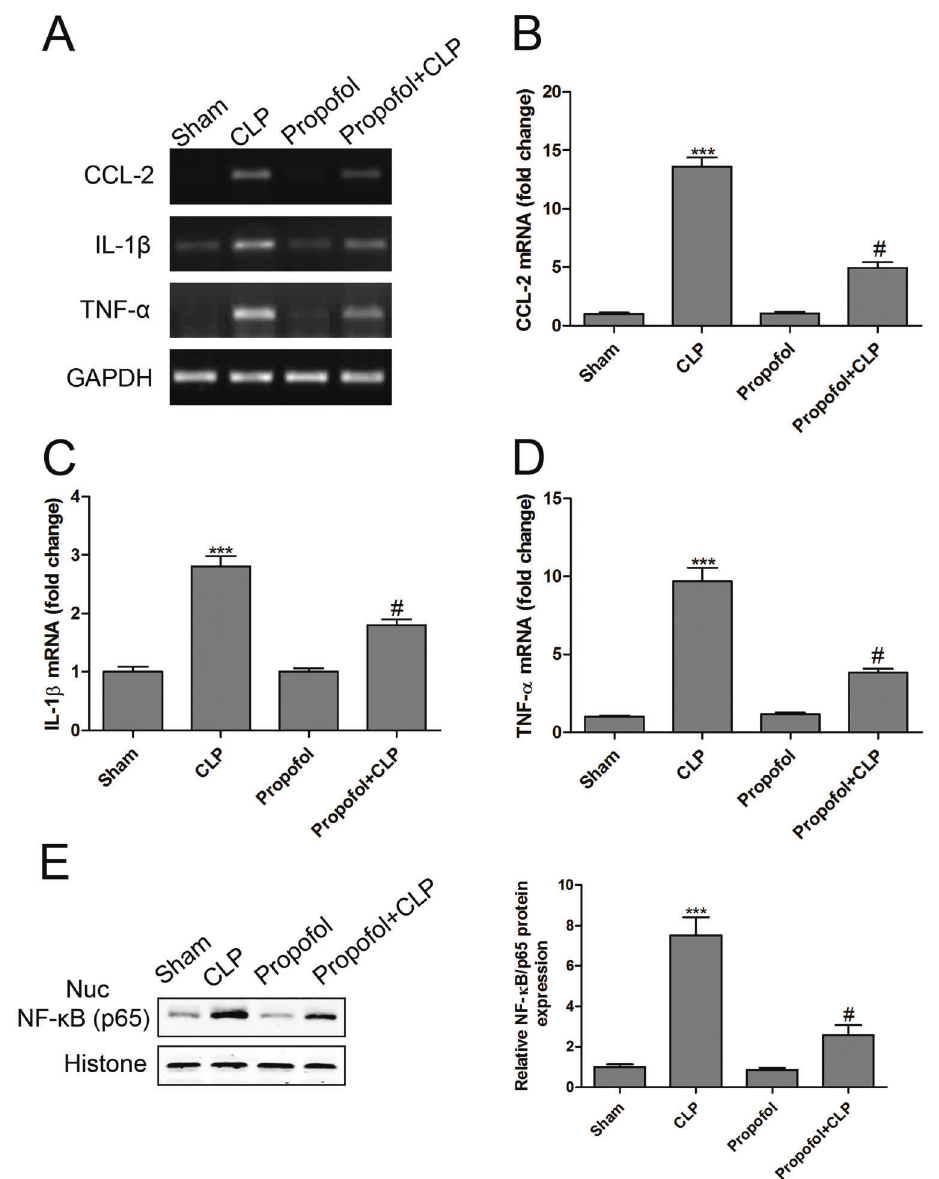
Figure 3. Propofol inhibited excessive in fl ammatory responses in septic mice. Renal mRNA levels of CCL-2 ( A and B ), interleukin (IL)-1 b ( A and C ), and tumor necrosis factor a (TNF- a ) ( A and D ) were measured by RT-qPCR and veri fi ed by agarose gel electrophoresis analysis. Protein expression of NF- k B (p65) in the nucleus (Nuc) was measured by western blotting ( E ). Data are reported as means ± SD (n=12 per group). ***P o 0.001 compared with the control group; # P o 0.05 compared with the cecal ligation and puncture (CLP) group